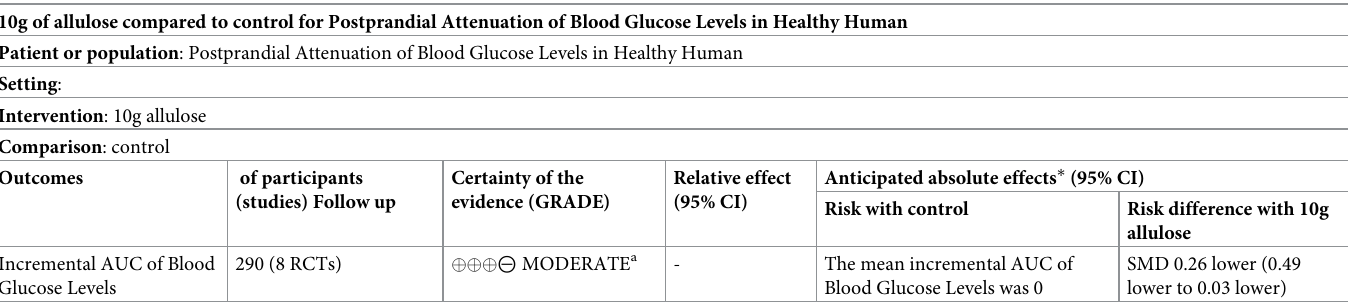
Table 1. Summary of findings for 10g of allulose intervention. Patient or population : Postprandial Attenuation of Blood Glucose Levels in Healthy